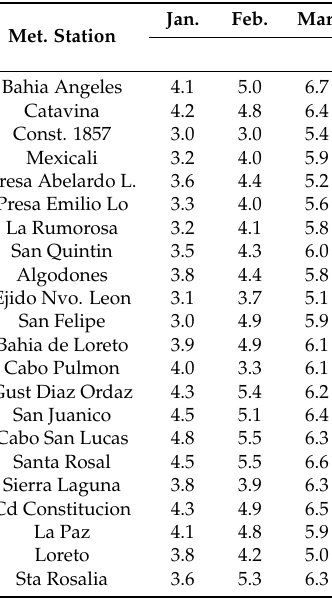
Figure 8. Daily irradiance patterns registered in Baja California Sur.